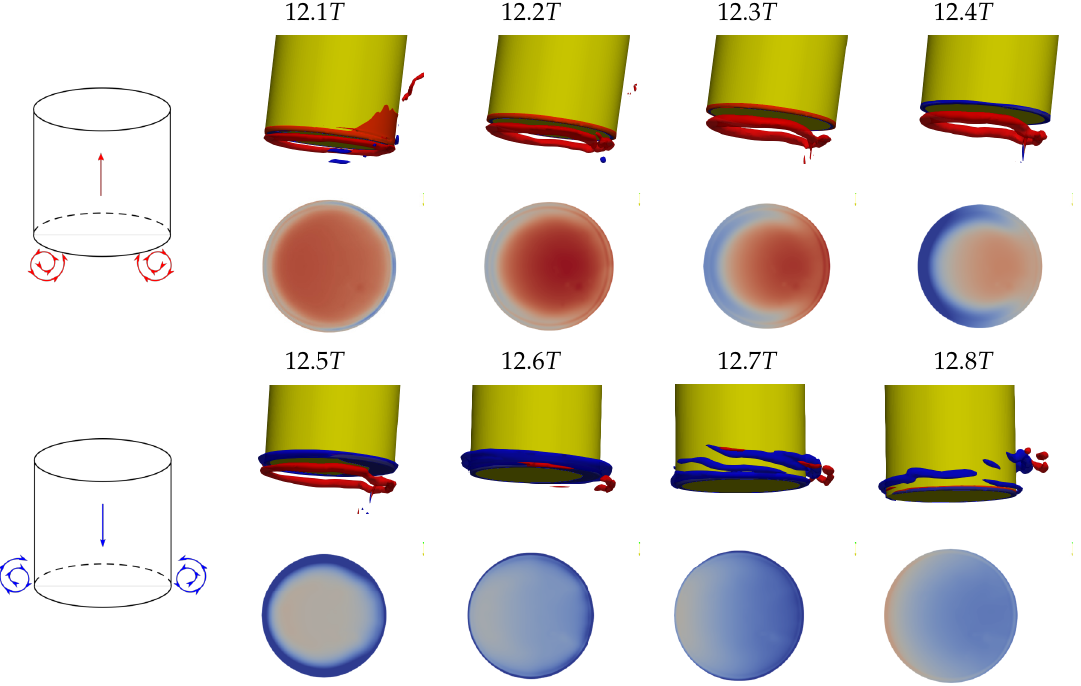
Figure 9. Vortex formation over the wave period T with corresponding dynamic pressure distribution on the bottom of the buoy for the W1 RANS model scale simulations. Vortices are visualized by the Q = 200 iso-surface and colored by rotation direction (inward rotation is blue and outward is red, see schematics on the left). Top two rows are upward motion, top bottom rows are downward motion. The colour-scale of the pressure distribution goes from blue to red in [ dimensionalised values. The wave propagates from left to right in all figures, while the positive y -direction is into the figure in the top row, and is directed downwards in the pressure